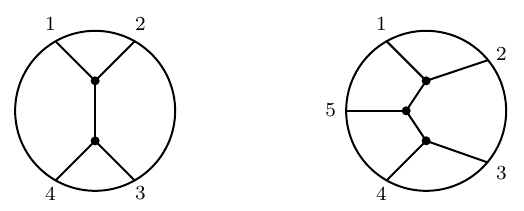
Figure 2 . Two examples of Witten diagrams corresponding to the expressions (4.84) and (4.85)